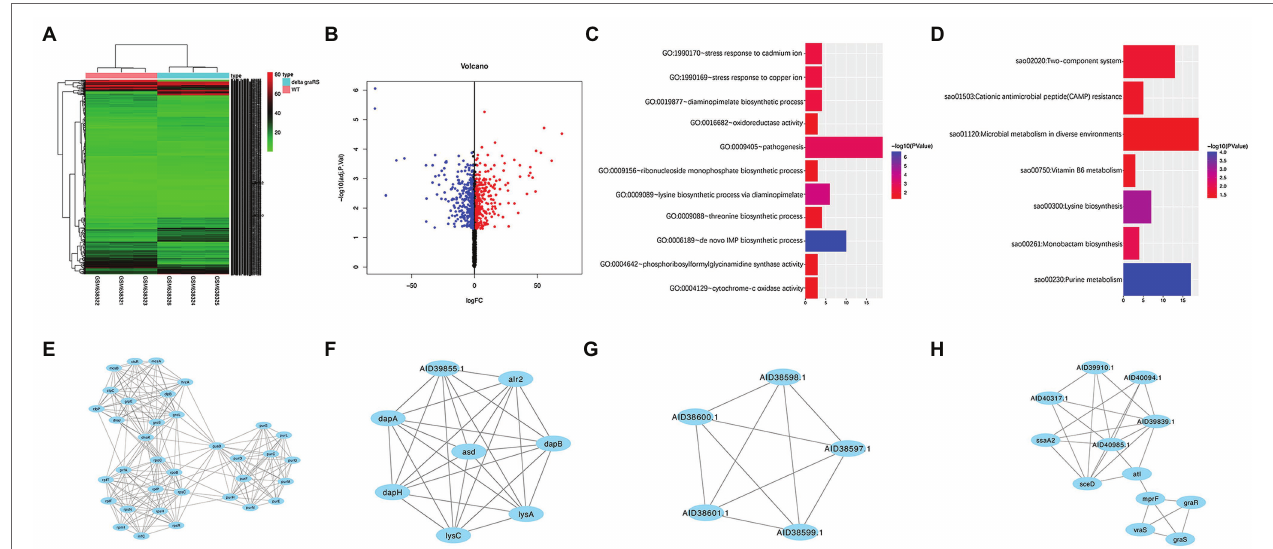
FIGURE 1 | Bioinformatic analysis of GSE26016 dataset. (A) Heatmap representation of differentially expressed genes in Staphylococcus aureus HG001 wild-type strain and the Δ graRS mutant. The highly expressed genes of HG001 Δ graRS mutant strain compared with HG001 WT were represented by the red areas and the lowly expressed genes were represented by the green areas. (B) Volcano plot of the differentially expressed genes (DEGs) in GSE26016 identified by “limma” package in R software. Blue dots represent the down-regulated genes and red dots represent the up-regulated genes of HG001 Δ graRS mutant strain compared with HG001 WT. (C) Gene Ontology (GO) functional enrichment result of DEGs in GSE26016. (D) Kyoto Encyclopedia of Genes and Genomes (KEGG) functional enrichment result of DEGs in GSE26016. (E–H) Four significant modules in GSE26016 obtained by protein– protein interaction (PPI) of 563 DEGs: (E) The most significant module detected by MCODE (score = 13.176). (F) The second significant module detected by MCODE (score = 8). (G) The third significant module detected by MCODE (score = 5). (H) The fourth significant module detected by MCODE (score =